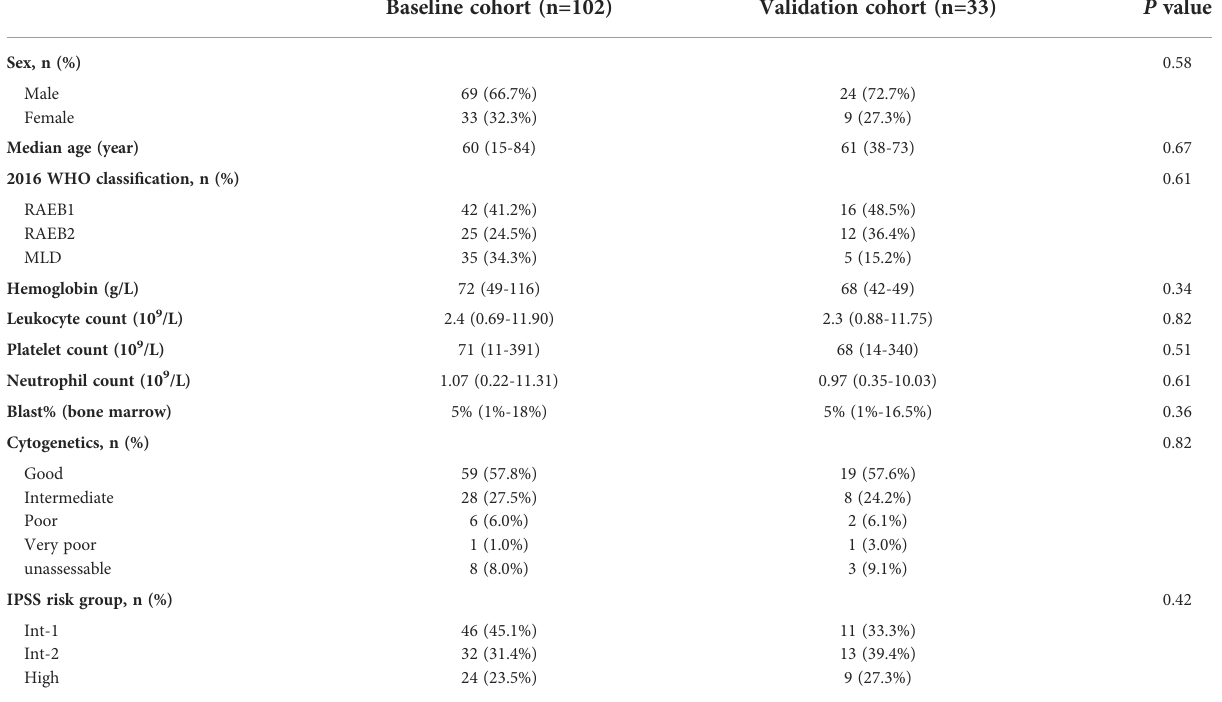
TABLE 1 Baseline characteristics of enrolled